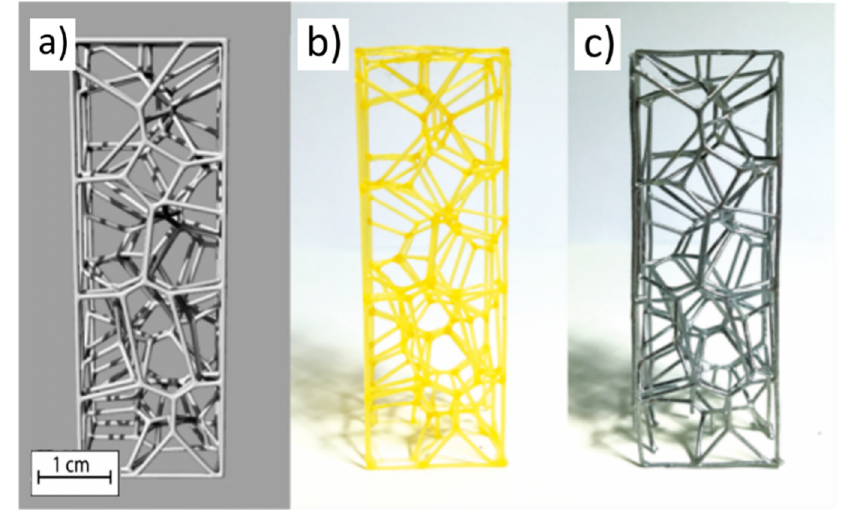
Figure 3. Comparison between ( a ) CAD model, ( b ) printed model, and ( c ) specimen obtained from foundry [23].